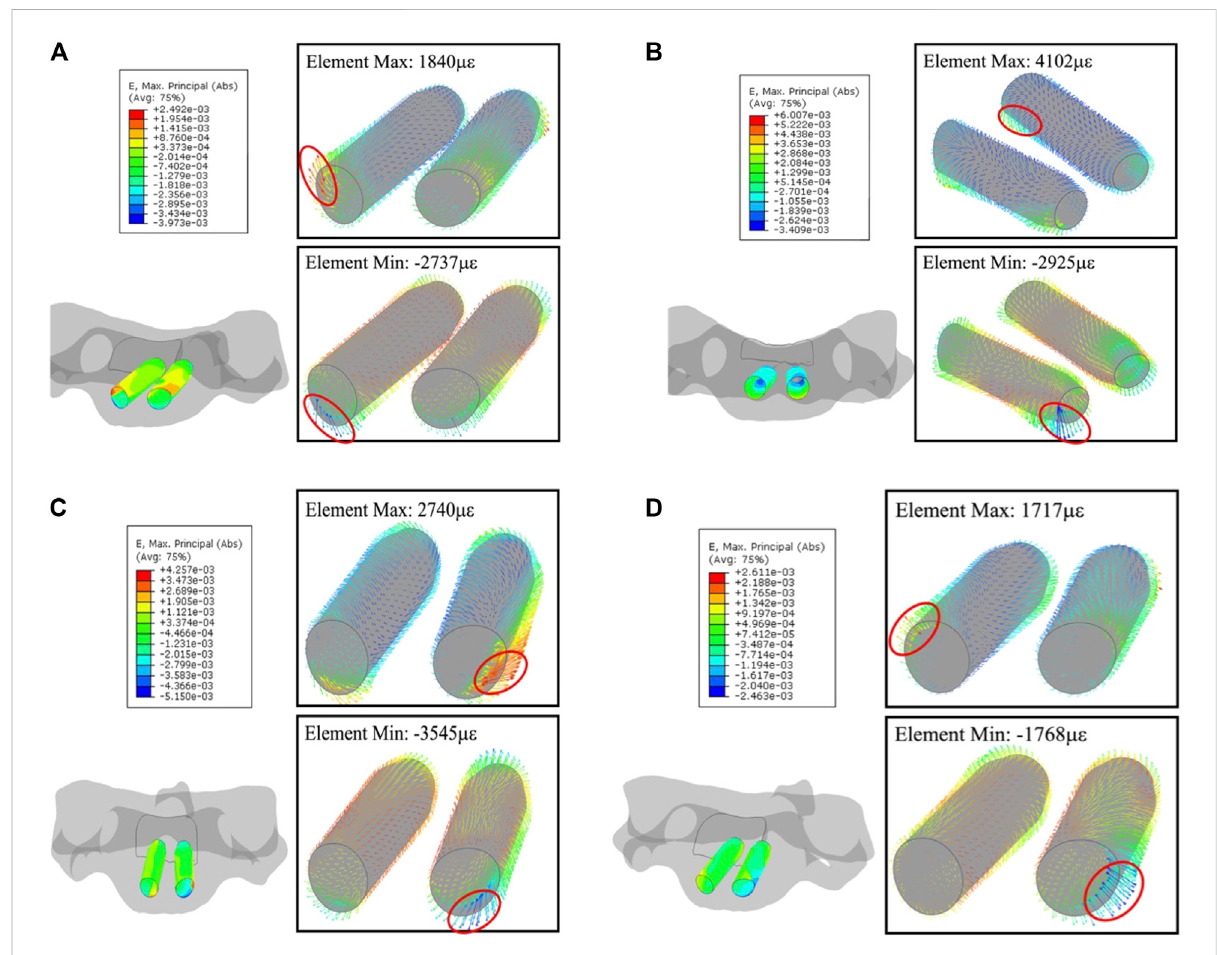
FIGURE 10 Principal-strain and deforming direction surrounding the trajectories in C5. (A) Flexion, (B) extension, (C) lateral fl exion, and (D) axial rotation. The left fi gure in each motion is the strain on the nodes, fi gures within the box display the strain in each element.